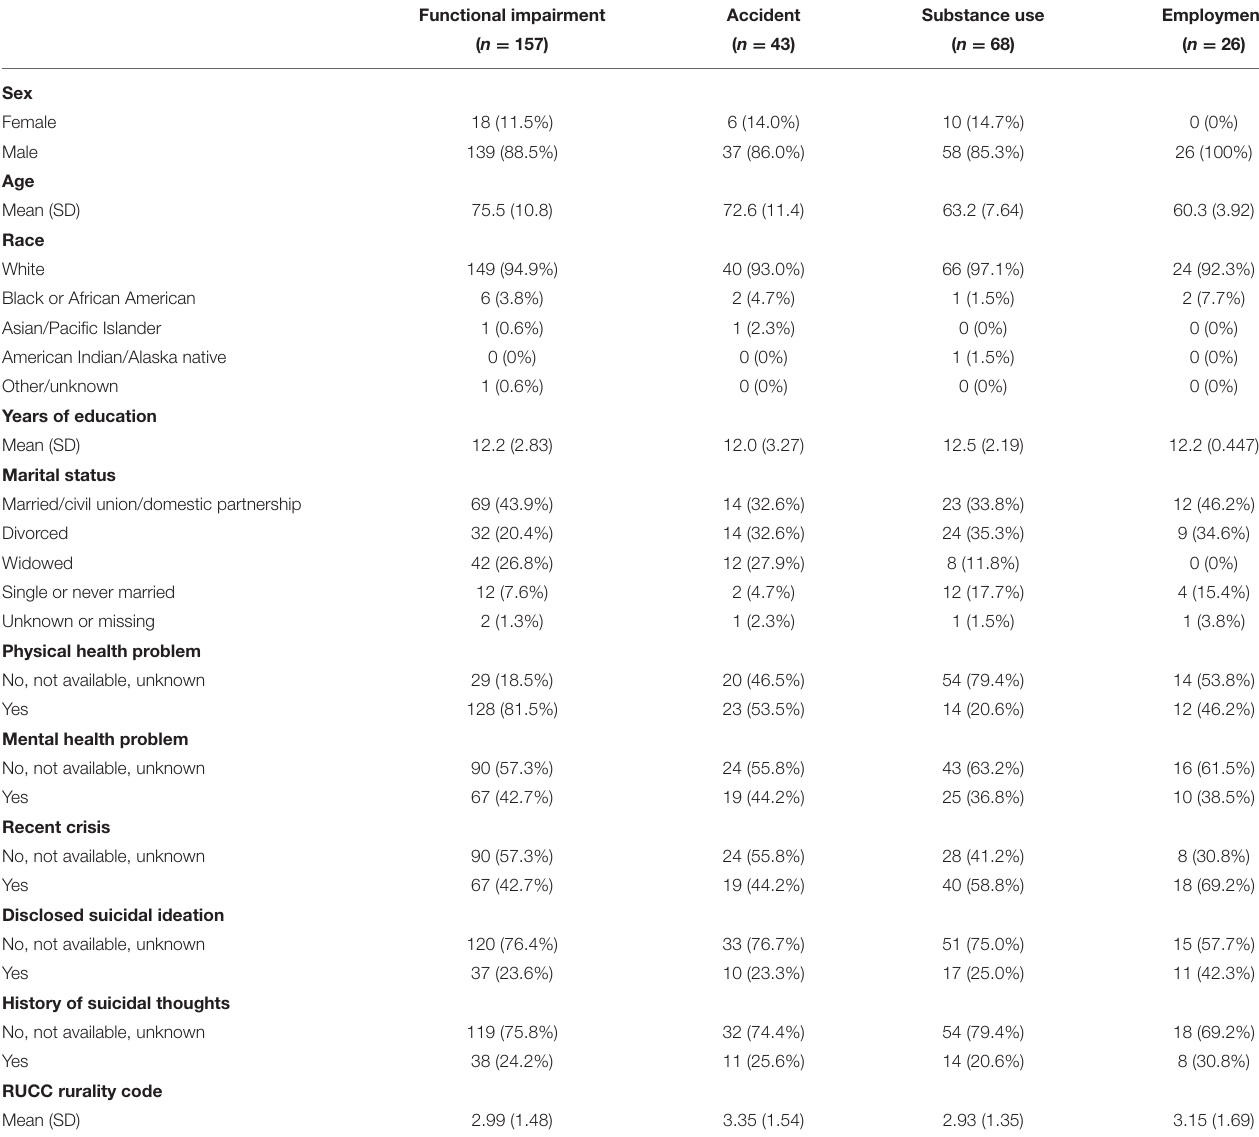
TABLE 2 | Description of driving cessation associated suicide decedents, by four themes identified via qualitative